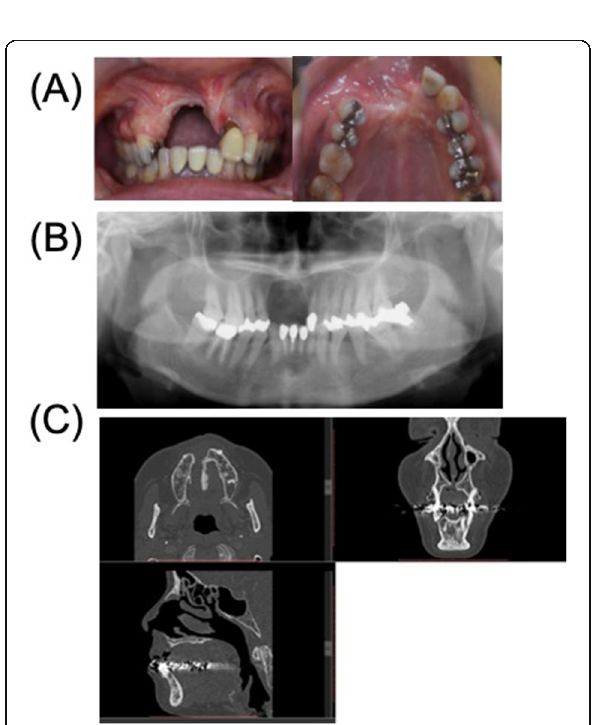
Fig. 2 Findings after partial resection of the maxilla. a Intraoral findings showing abundant scar tissue formation. b Postoperative radiograph. c Postoperative cone-beam CT showing segmental defect in the anterior maxilla